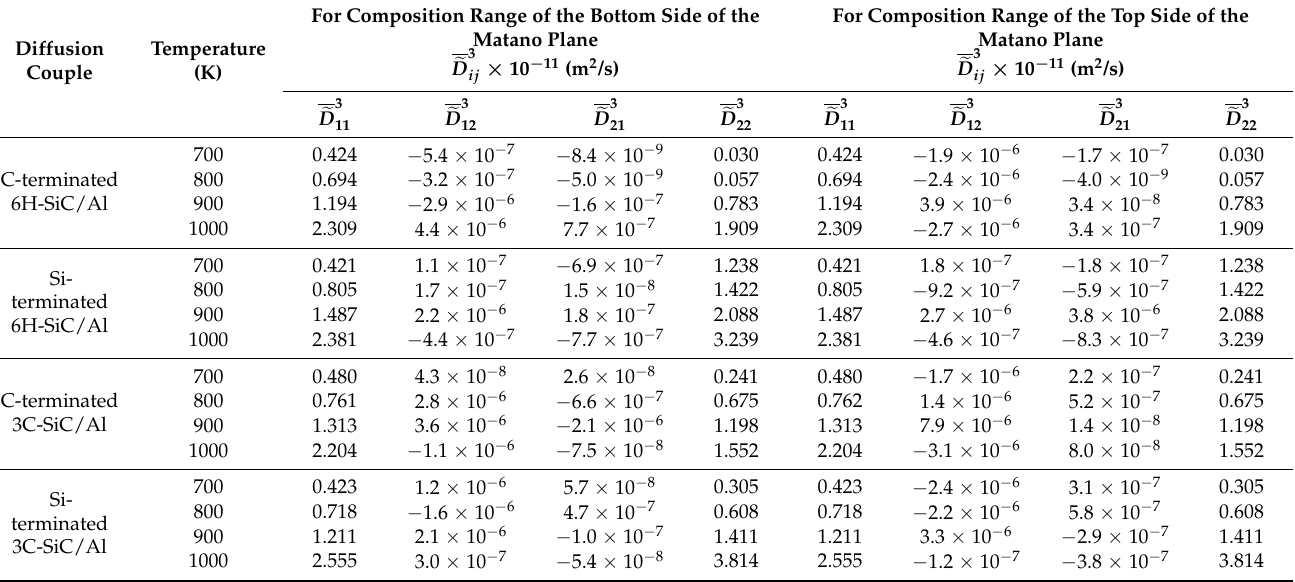
Table 2. Average values of ternary main and cross-interdiffusion coefficients on each side of the Matano plane after maintaining the system with 10% vacancy defects in SiC at the preset temperature for 6 ns (indices: 1 = Al; 2 = Si; and 3 = C).